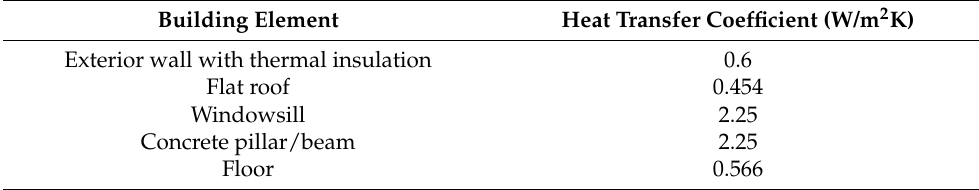
Table 5. Thermal properties of structural elements.